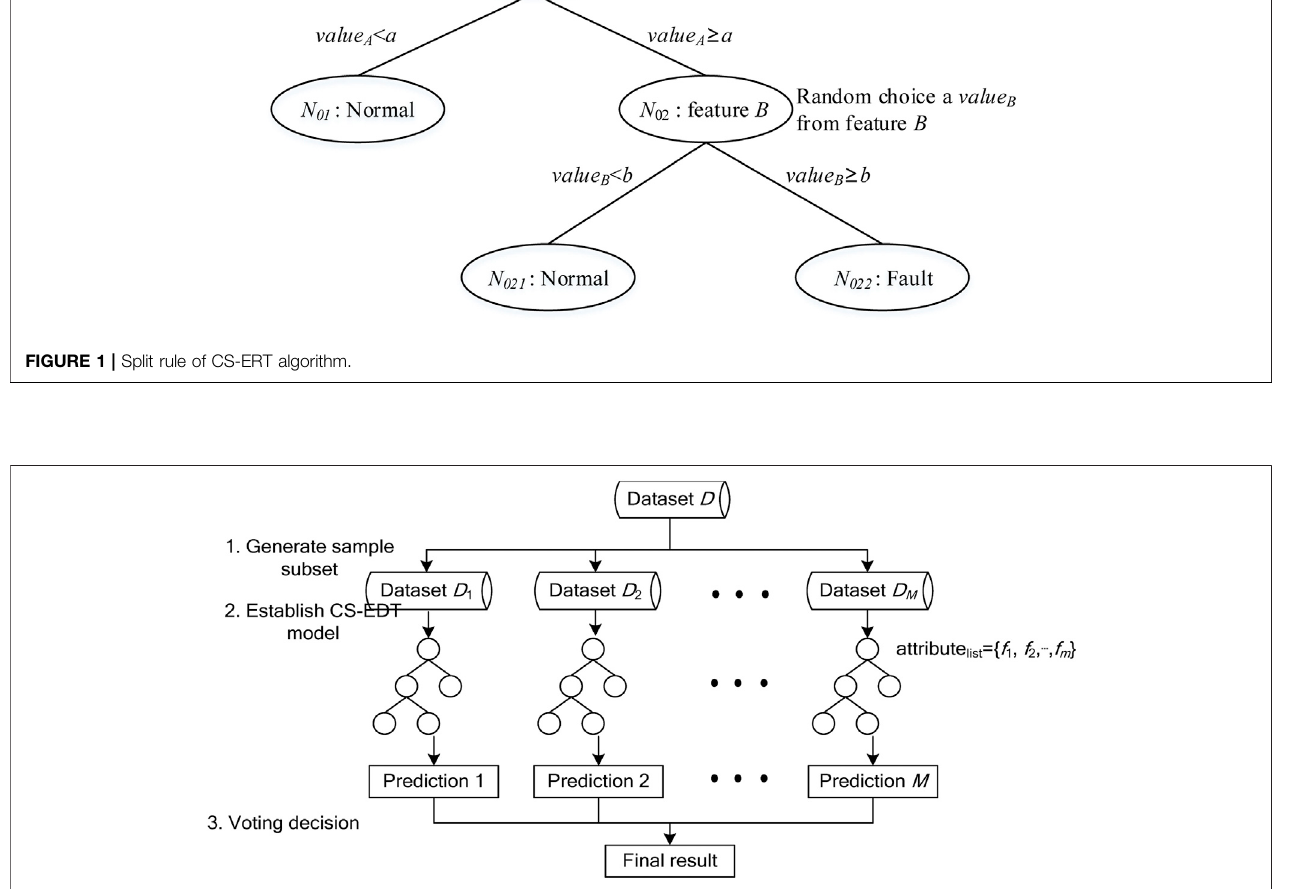
FIGURE 2 | Cost-sensitive extremely randomized trees